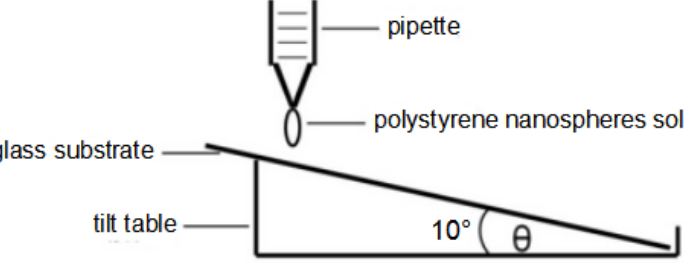
Figure 2. Schematic diagram illustrating the drop-coating method completing the self-assembly arrangement.